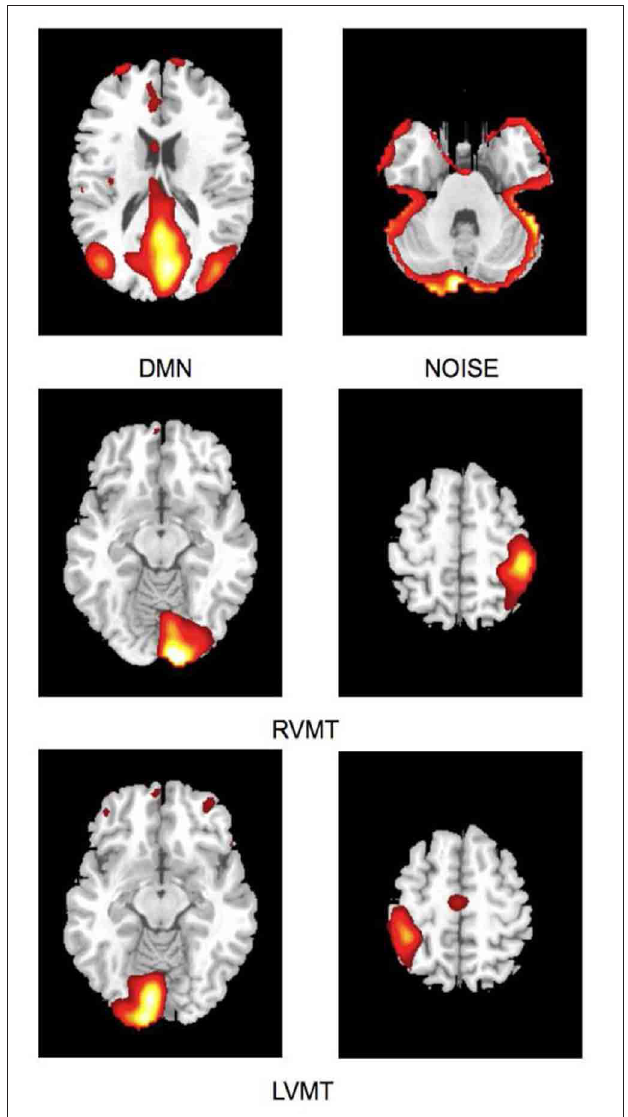
FIGURE 2 | Spatial maps of ICs considered in the simulation obtained from Group ICA 20 ICs. For ease of visualization only the relevant slices are reported here. First row depicts default mode network (DMN) and residual motion artifact (Noise). Second and third rows depict the two task-related ICs, right visuo-motor task (RVMT) and left visuo-motor task